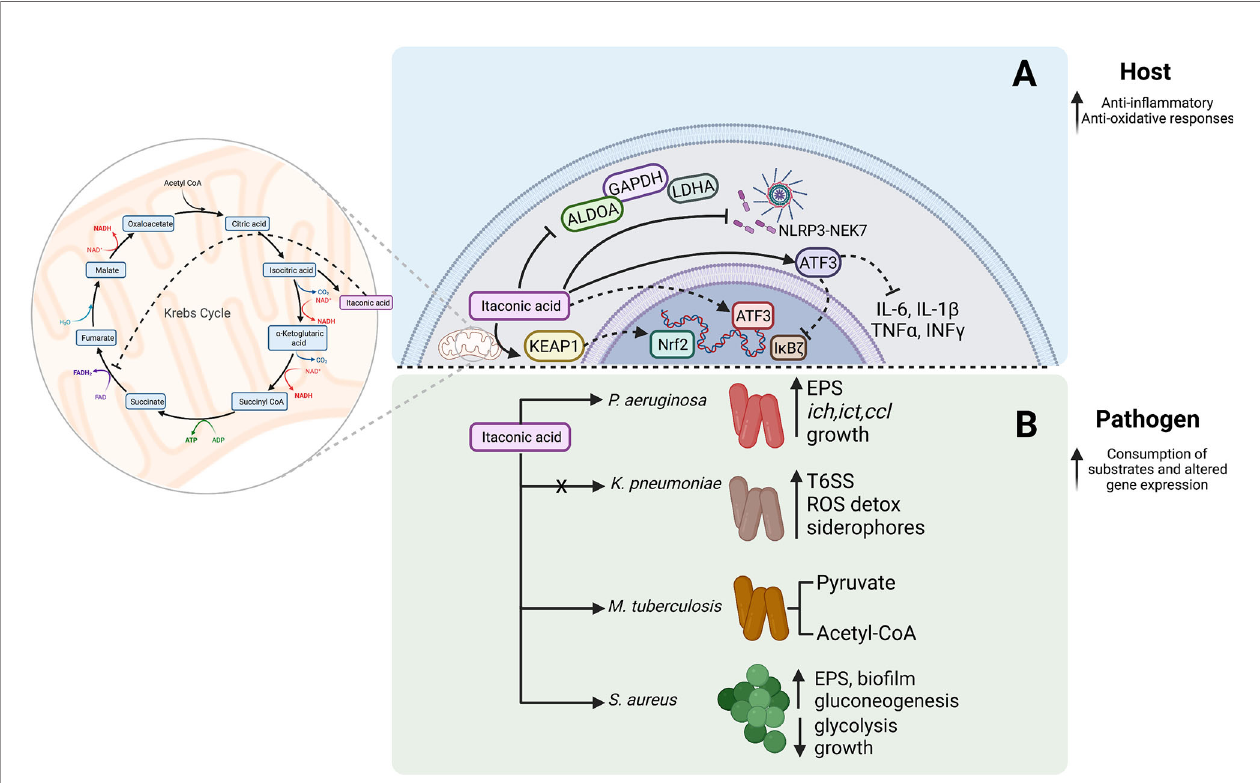
FIGURE 2 | Itaconate effects on host signaling and bacterial survival. (A) Itaconate targets host signaling and suppresses in fl ammation. (B) Itaconate fuels bacterial metabolism and